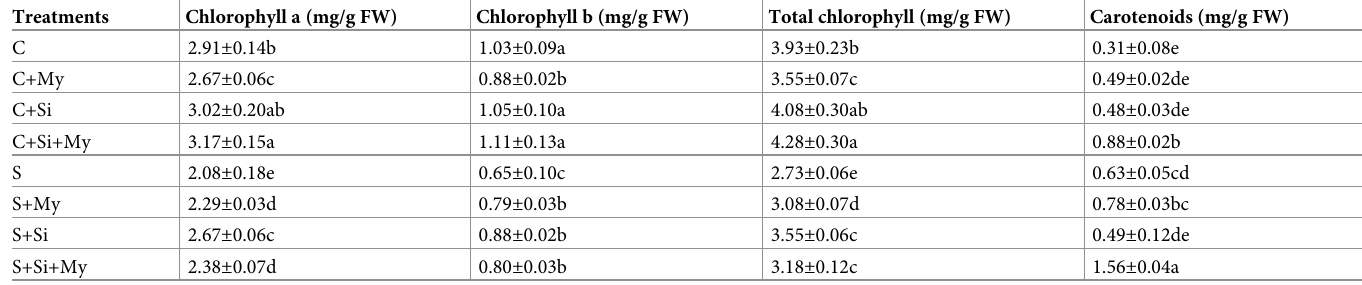
Table 3. Variation among the different treatments for leaf pigments of Brassica juncea when treated with silicon along with mycorrhizal inoculation of under water stress in the influence of silicon and mycorrhizal inoculation.